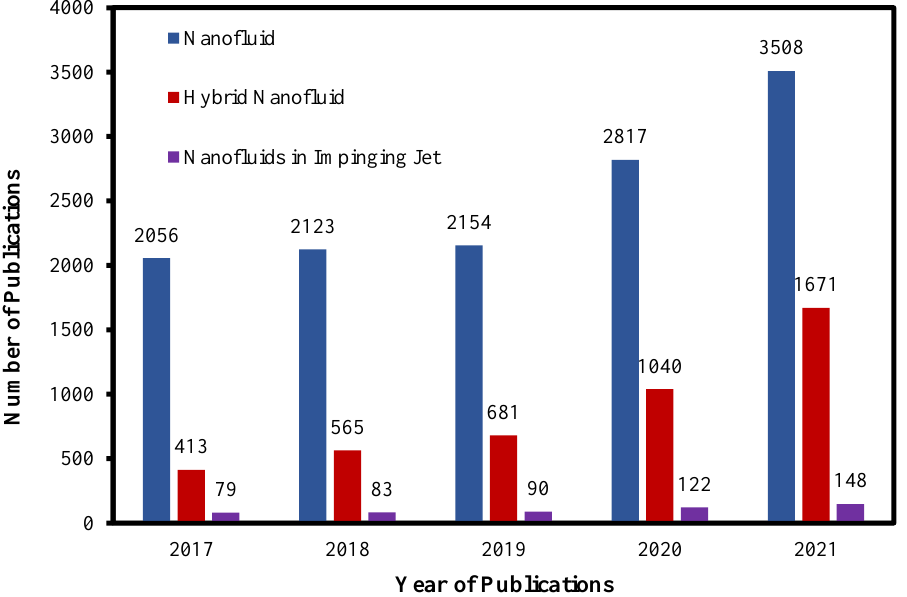
Figure 2. “Hybrid”, “Nanofluid” and “Jet Impingement” found in journal article titles or keywords. Searched by Science Direct 18 March